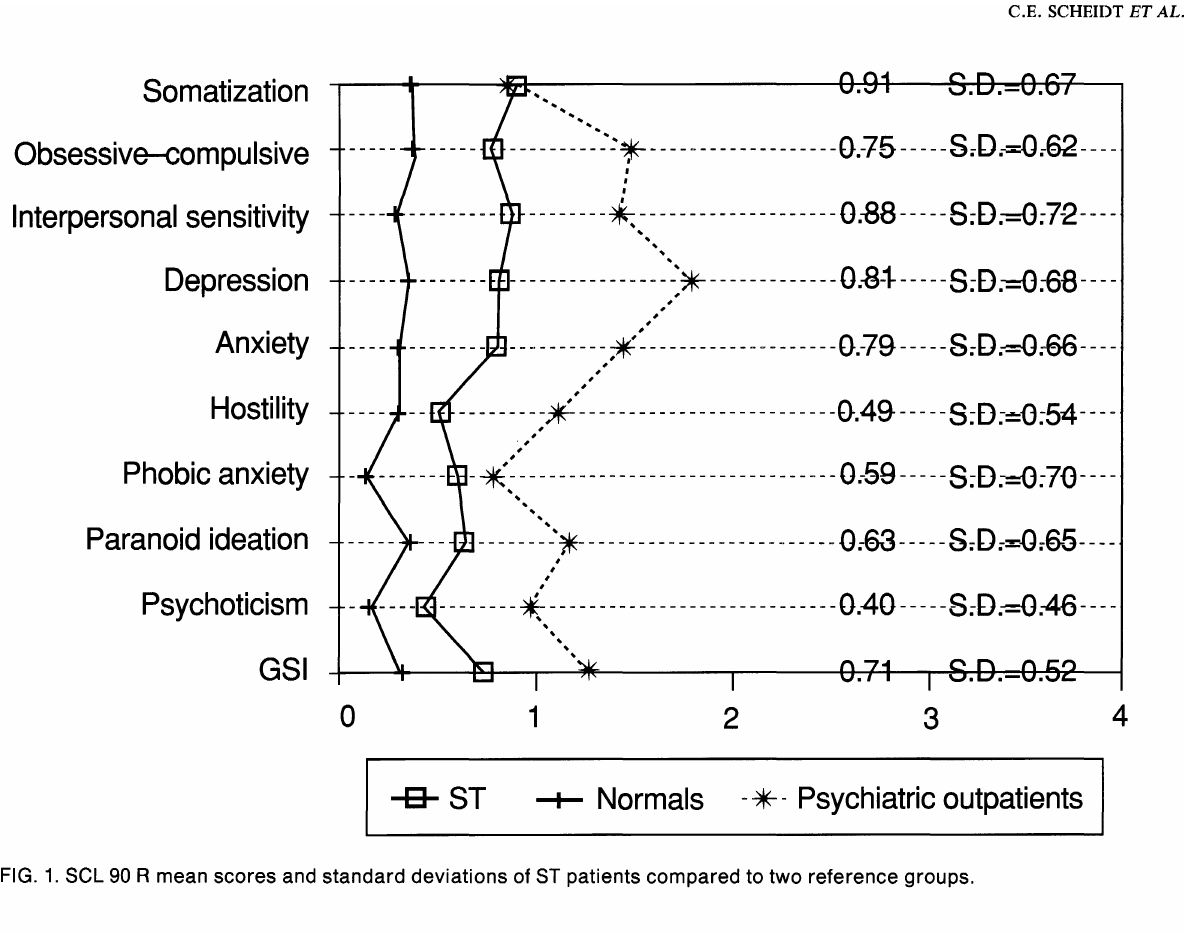
FIG. 1. SCL 90 R mean scores and standard deviations of ST patients compared to two reference